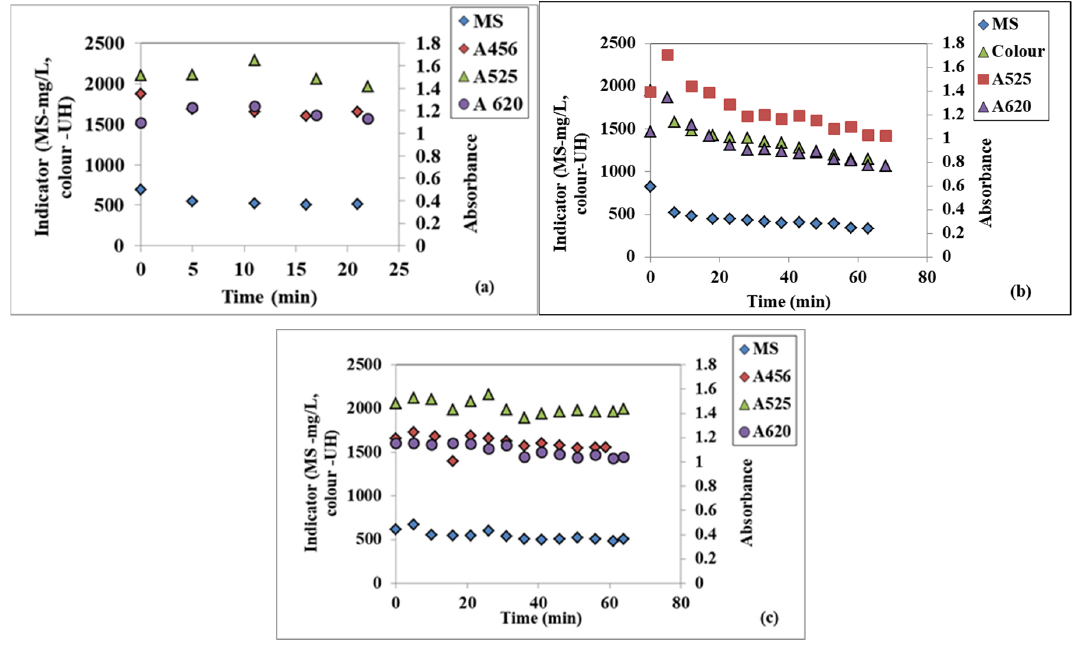
Figure 2. Variation in the time of the textile WW suspended solids (MS) and colour at 10 L/h flowrate and three different rotational speeds: ( a ) 100 rpm, ( b ) 300 rpm, ( c ) 500 rpm. Additionally, the same variation in the time of quality indicators at a WW flowrate of 30 L/h